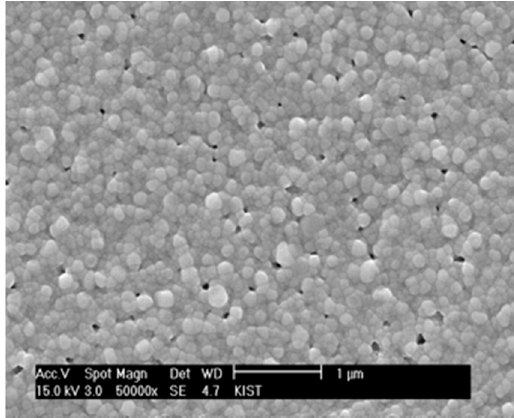
Figure 7. Sintered surface of a YSZ thin electrolyte layer obtained with the chemical solution containing 5 vol % YSZ nanoparticles.